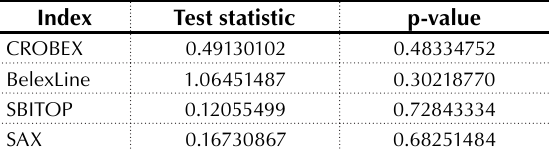
Table 5. January effect test results